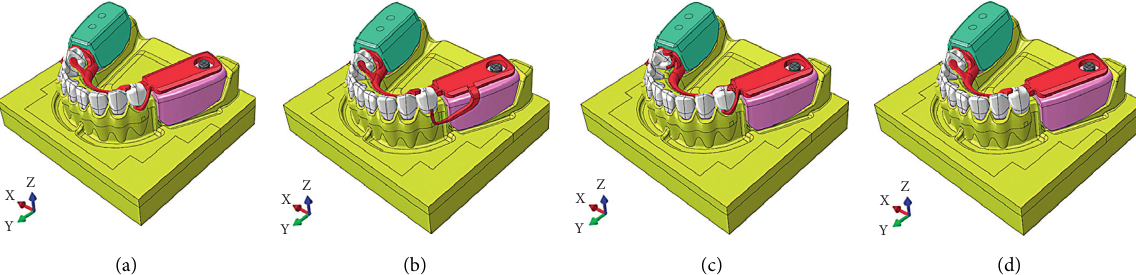
Figure 3: The 3D FEA models of bilateral distal extension base mandibular arch with the RPD metal framework with the different designs of retentive component and the acrylic denture bases on edentulous areas: (a) the model with the RPA clasps, (b) the model with the RPI clasps, (c) the model with the Akers cast clasps, and (d) the disto-occlusal rest seats with no retentive components as